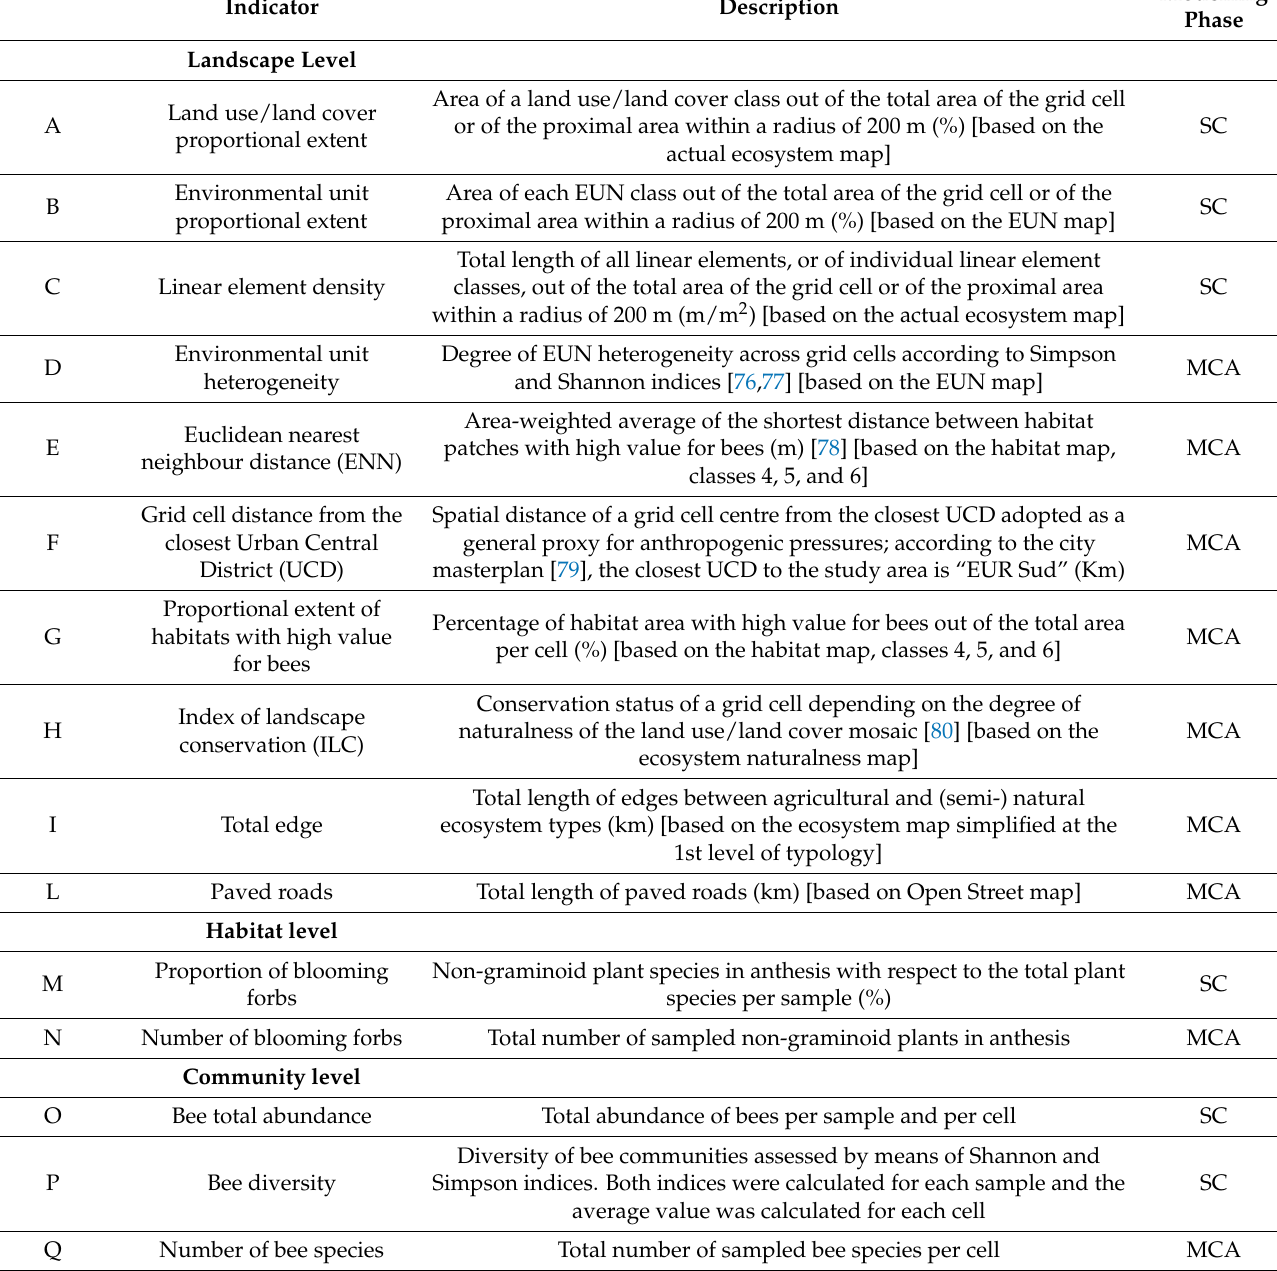
Table 1. Adopted indicators for processing input data at the landscape, habitat, and community level, and respective application in the modelling phases